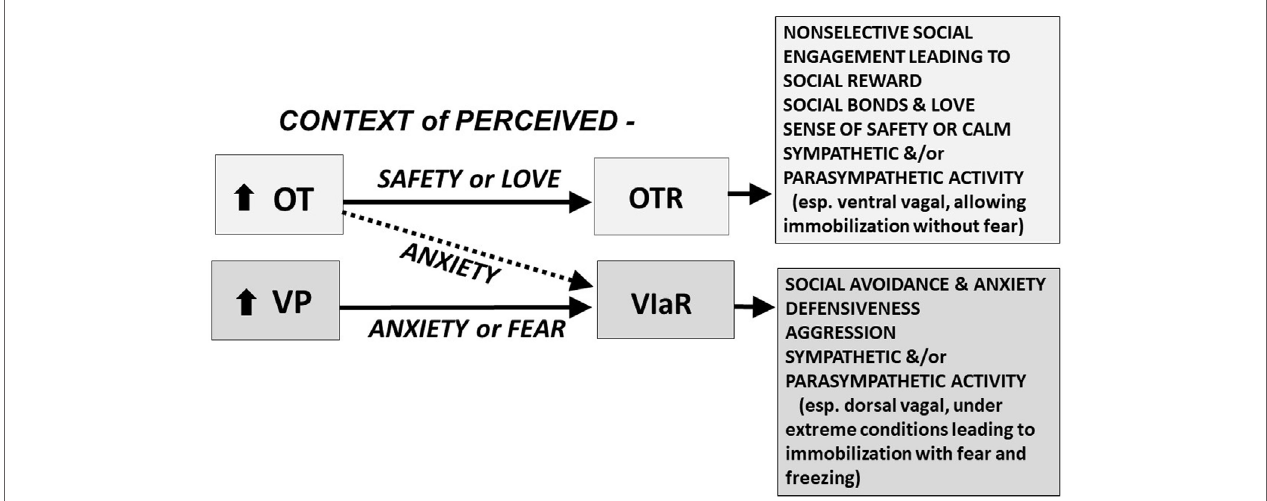
FiGURe 1 | The oxytocin (OT) and vasopressin (VP) pathway includes the OT receptor (OTR) and the V1a receptor (V1aR). We hypothesize that in a context of perceived safety, OT predominately acts on the OTR, facilitating “immobility without fear,” including high levels of social engagement, social bonds, and social reward; these behaviors are at the heart of mammalian reproduction and “love.” VP and the V1aR are more ancient and probably become dominant under conditions of anxiety or trauma. In a context of anxiety or fear, OT may function primarily through effects on the V1aR; under these conditions both OT and VP may act, via the V1aR, to induce additional anxiety, social avoidance, defensiveness, aggression, and fear. We hypothesize that under extreme conditions, fear and the V1aR may dominate leaving the individual vulnerable to “immobility with fear,” which may lead to freezing and cognitive and emotional dissociation. These responses are mediated in part by interactive effects of OT and VP on the sympathetic nervous system and the parasympathetic nervous system, including the ventral vagal complex (necessary for social engagement) and the dorsal vagal complex (functioning to conserve energy and protect against shutting down in the face of trauma) (5). Other components of this adaptive system including the V1bR, and many other molecules or receptors, including those regulated by CRH, dopamine, opioids, GABA, and serotonin, play a role in the expression of social and defensive behaviors. The differential actions of OT and VP are dose, time, and brain-region dependent. The OT and V1a receptors are affected by genetics and epigenetic tuning, especially in early